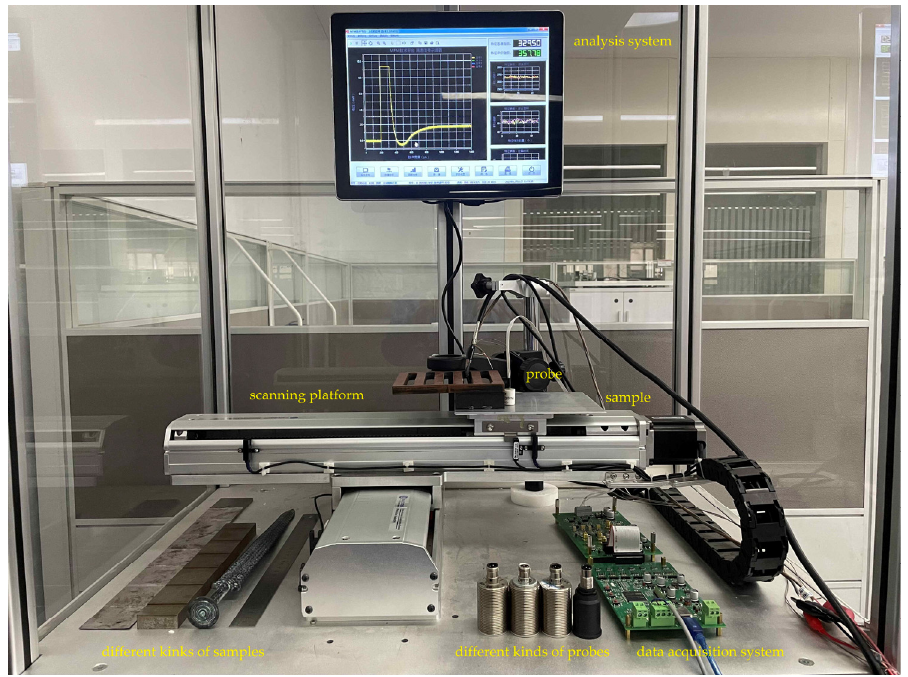
Figure 2. Photograph of the experimental setup.